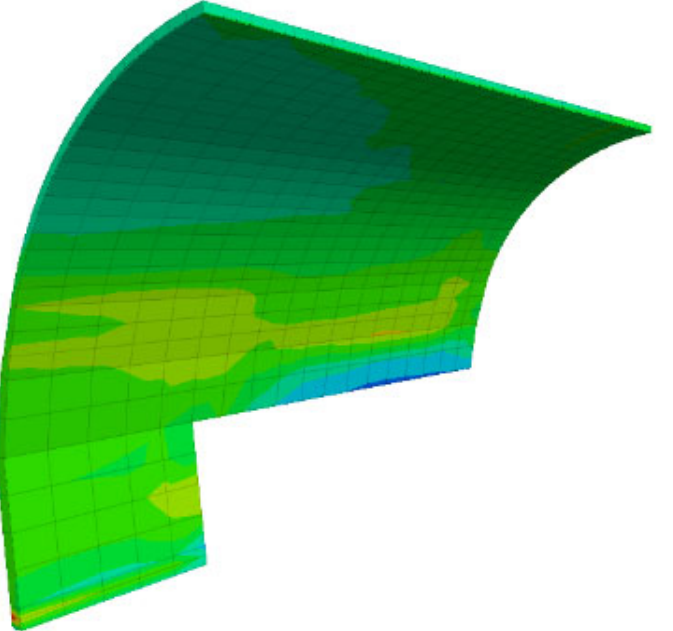
Figure 33. Minor principal stress contours σ 3 (in N/m 2 ) in concrete elements from blue − 2.7 × 10 5 , to red 1.7 × 10 5 . Minimum parameters.